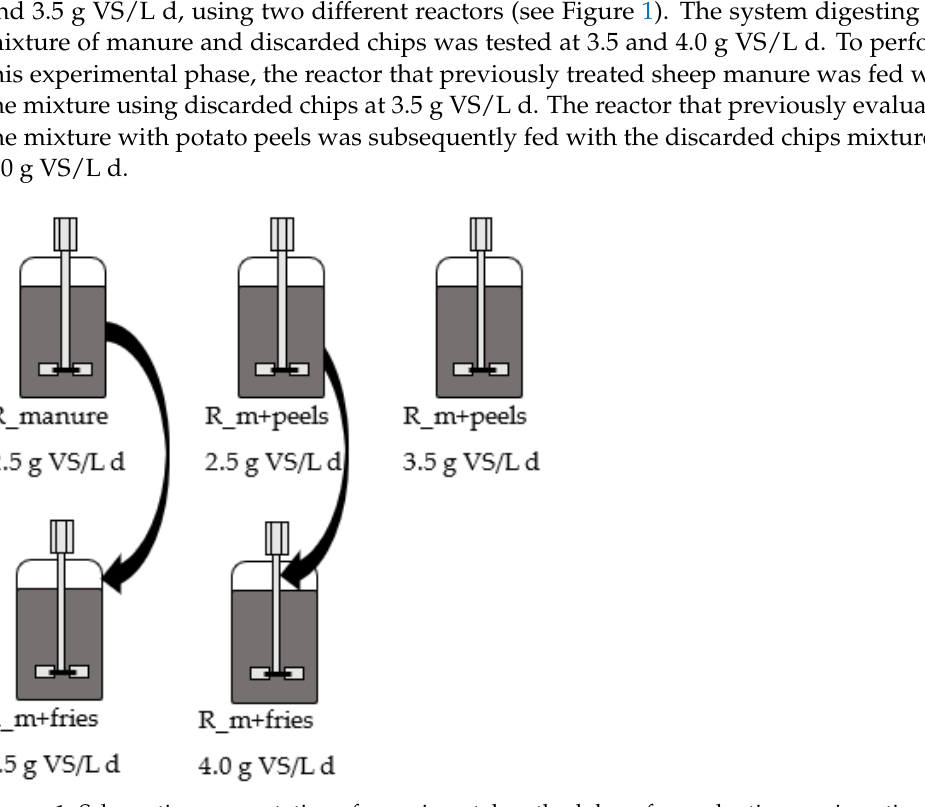
Figure 1. Schematic representation of experimental methodology for evaluating semi-continuous reactors for digesting manure (R_manure) and mixtures with potato peels (R_m + peels) and chips (R_m + fries).